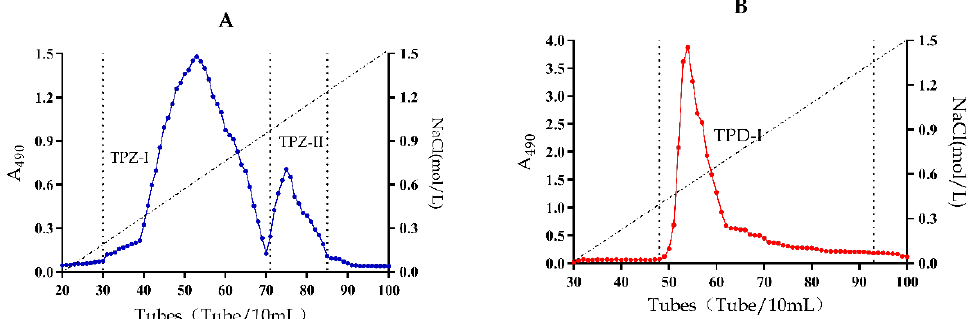
Figure 1. The carbohydrate elution profiles monitored by the phenol-sulfuric acid assay. ( A ) Ion- exchange chromatography elution profile of crude polysaccharide from fruit bodies of T. panzhihuanense . ( B ) Ion-exchange chromatography elution profile of crude polysaccharide from fruit bodies of T. pseudoexcavatum .